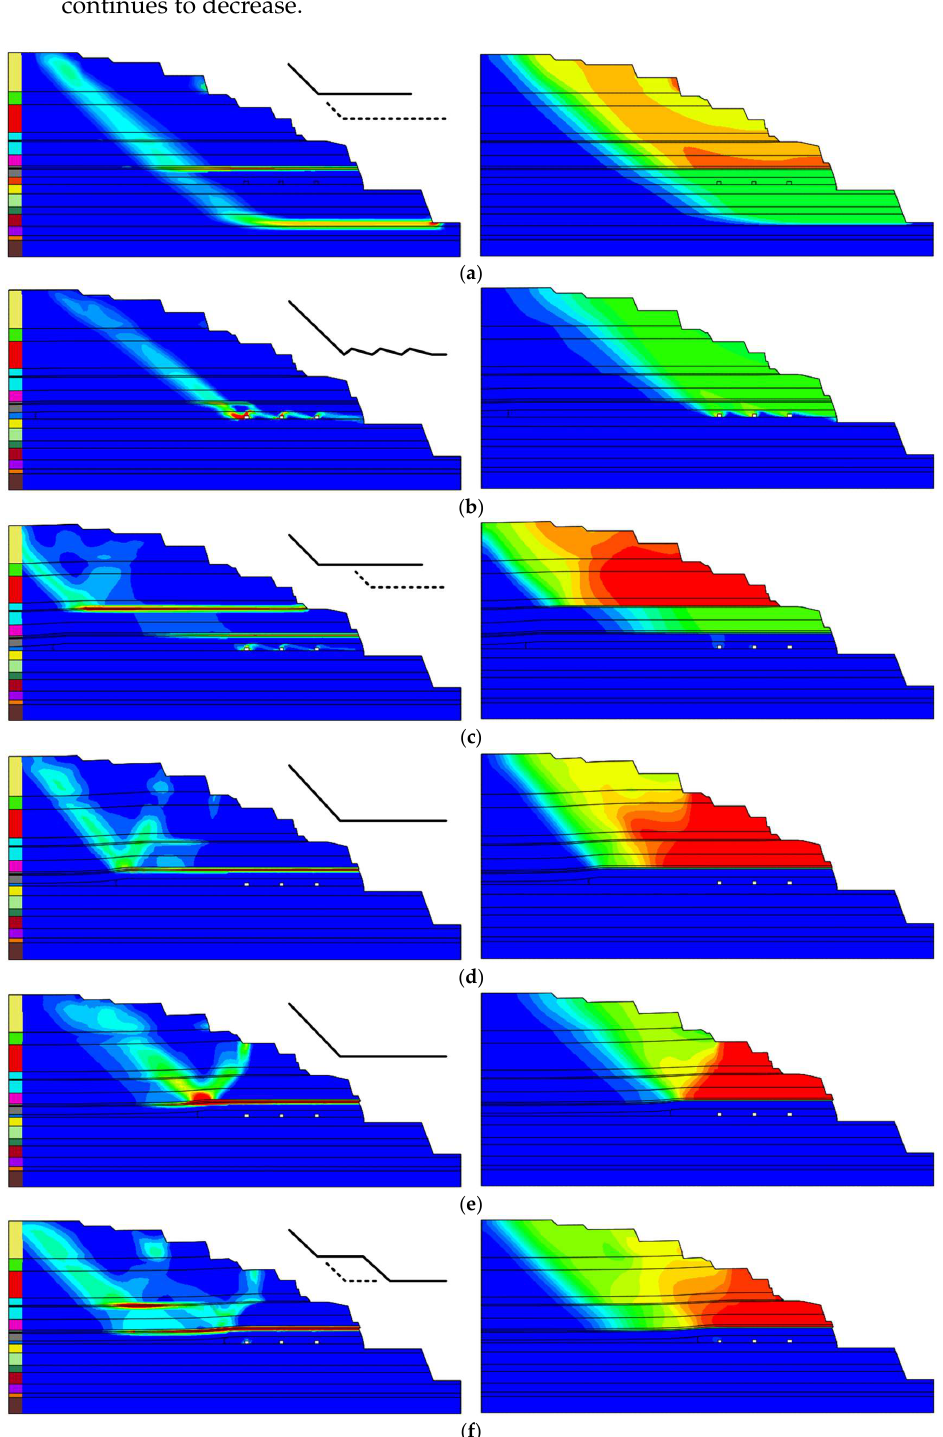
Figure 14. Slipping surface position and safety factor of disturbed slope. The subfigures presented on the left side show the plastic shear strain rate nephograms, and those on the right side show the displacement nephograms. ( a ) The initial slope, F = 2.01; ( b ) advancing distance = 30 m; F = 1.90; ( c ) advancing distance = 50 m; F = 1.84; ( d ) advancing distance = 120 m; F = 1.72; ( e ) advancing distance = 210 m; F = 1.47; ( f ) advancing distance = 240 m; F = 1.20.